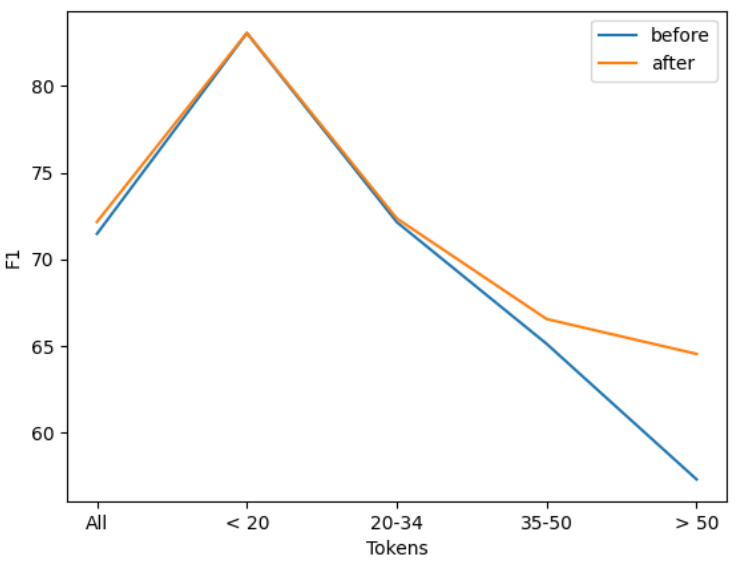
Figure 7. The changes of F1-scores before and after added Bi-LSTM_ATT network when using different tokens. Some improvements are seen after it is added